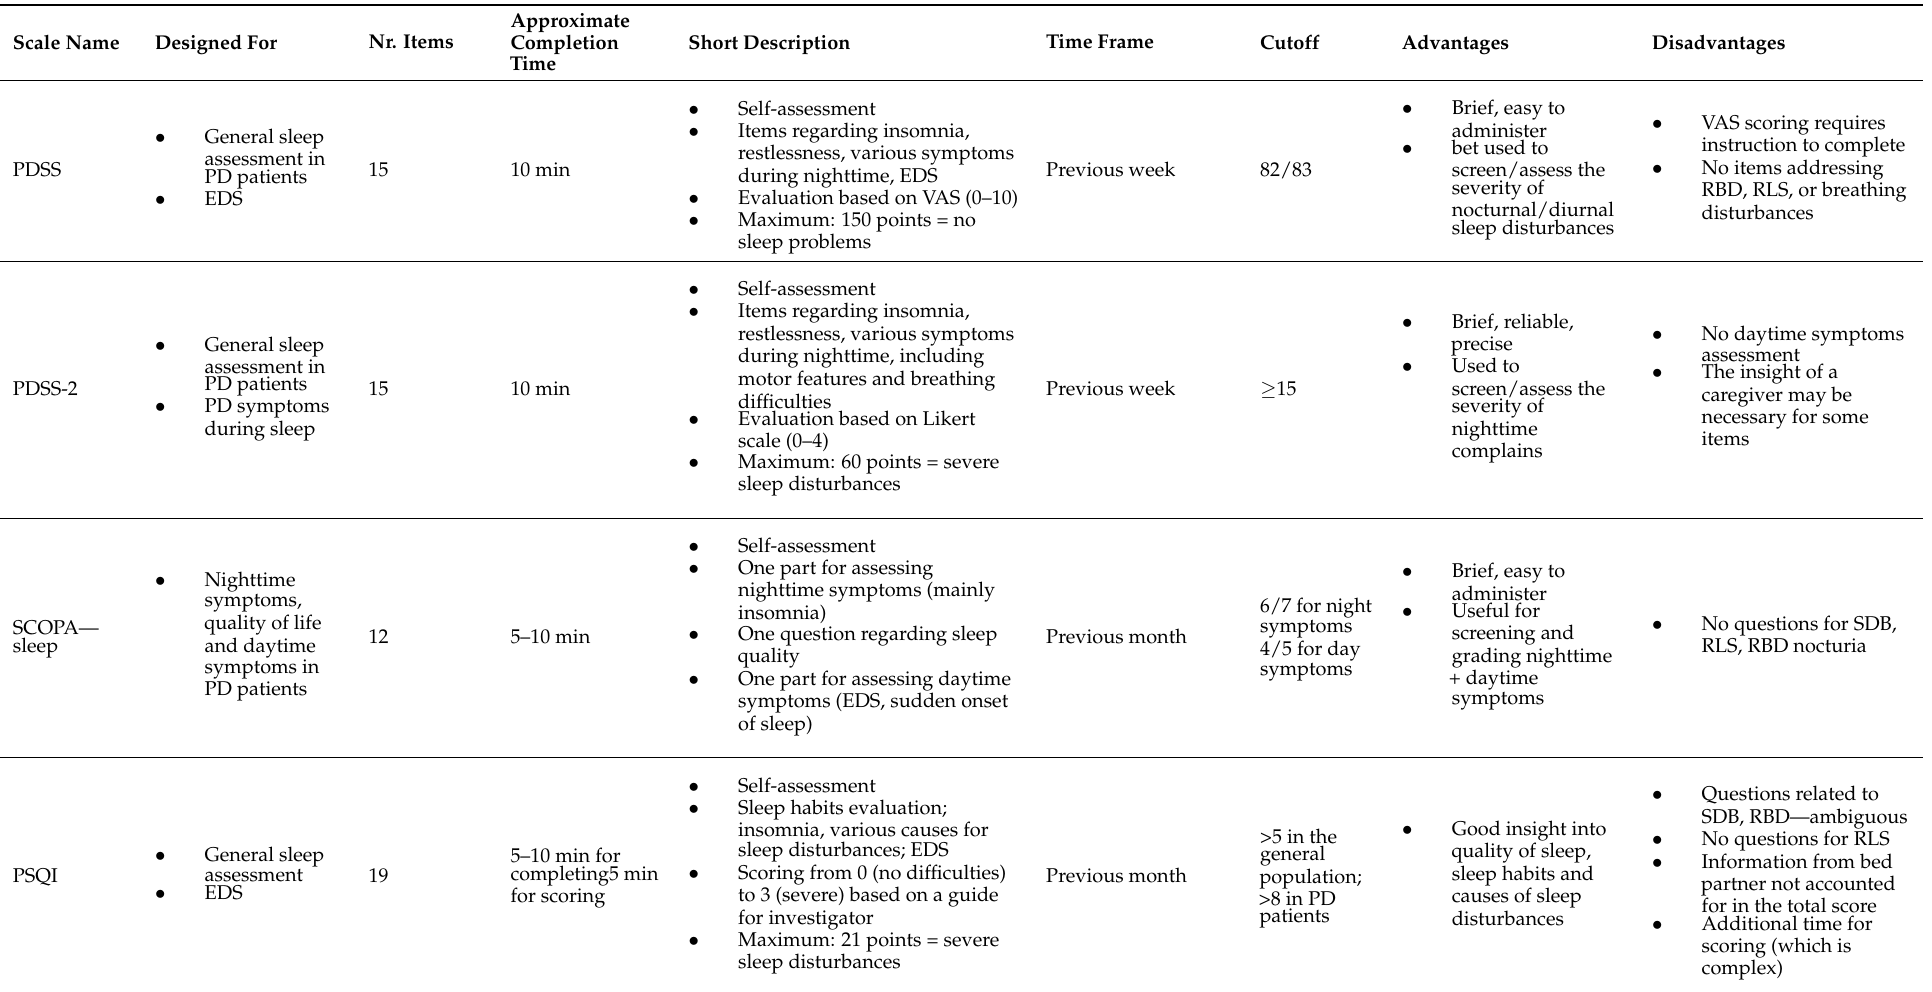
Table 1. Main characteristics of the most commonly used scales for the assessment of insomnia and sleep